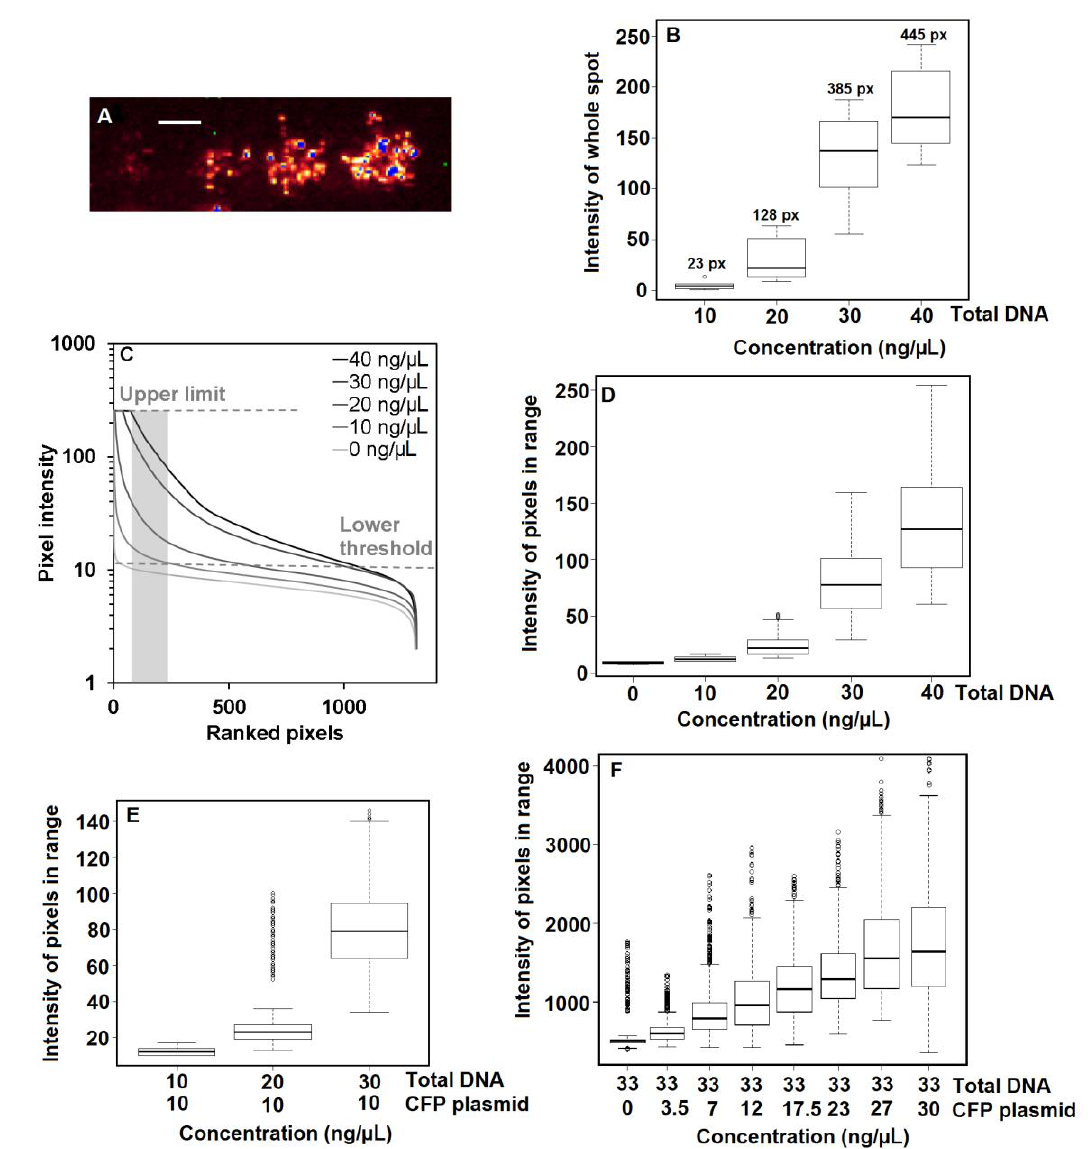
Figure 3. The effect of total DNA concentration and coding DNA concentration on protein expression displayed as pixel intensity. The boxplots of Figure 3 show the distribution of spot intensities per category. Each category includes about 10 spots. The black line indicates the median value of the data distribution; the box represents the first and third quarter of the data distribution; and the whiskers represent the minimum and maximum value of the dataset. The open circles are outliers in the dataset. ( A ) Fluorescence image of four spot types representing from left to right 10, 20, 30 and 40 ng/µL total DNA. The image is shown with a range indicating LUT where over-exposed pixels display in blue. Scale bar = 200 µm. ( B ) Average spot intensity (based on pixels above background intensity including saturated pixels) of spots containing total DNA at concentration of 10 ng/µL ( n = 9 spots), 20 ng/µL ( n = 8 spots), 30 ng/µL ( n = 9 spots) and 40 ng/µL ( n = 8 spots). Numbers above the boxplots indicate the average amount of pixels of the spots. ( C ) Pixel ranking of spots containing 0 ng/µL, 10 ng/µL, 20 ng/µL, 30 ng/µL and 40 ng/µL total DNA. The grey dashed lines show an upper limit (with a value of 256) and a lower threshold (background level with a value of ~20). The grey area (Pixels 110–212) is the range of pixels where all spots can be compared using the same pixel range and within the upper and lower limits. ( D ) Boxplots of CFP fluorescence intensity of all pixels in range (grey bar) as indicated in (C) with increasing total CFP plasmid DNA concentration. ( E ) Boxplots of CFP fluorescence intensity of all pixels in range with 10 ng/ µ L ( n = 9 spots), 20 ng/ µ L ( n = 9 spots) and 30 ng/ µ L ( n = 9 spots) total DNA and constant 10 ng/ µ L CFP plasmid DNA. ( F ) Boxplots of CFP fluorescence intensity of all pixels in range with increasing CFP plasmid DNA concentration and constant total DNA concentration. The array of Figure 3F was measured on a different array (all conditions n = 26 spots) with a 12-bit intensity scale (4096 levels), leading to higher intensity values and a different pixel range for intensity comparison than ( D , E